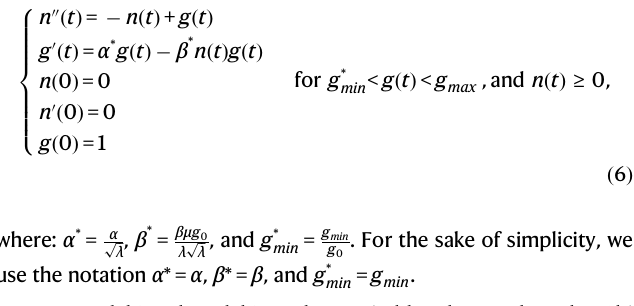
Figure 2. (B) Numerical simulations of Model 1 for 0 ð 0 Þ =0 g − 6 , g ≤ α ≤ 11, λ =1, μ =1, n max =70, 0.01 0 =0, n 0 =1, g min =10 0.2 ≤ β ≤ 10, Δ α =0.2, and Δ β =0.2. (A) As in B, with α =4, β =1 (susceptible phage), α =5, β =0.5 (fast phage), and α =0.3, β =0.2 (slow phage). – Figure 3. (A) Numerical simulations of Model 2 with: φ =50, γ =2 δ =4. The rest of the parameters are the same as in Fig. 2. (B) Model 2, using equations (4) instead of equations (3) to simulate the dynamics of Abi sensors, with γ =2.2, δ = − 0.2, and= s max =20. (C) Numerical simulations of Model 2 with: φ =50, γ =5, and δ =2 (light gray region) and with φ =30, γ =1.5, and δ =0.5 (dark gray region). (D) Same as in A.